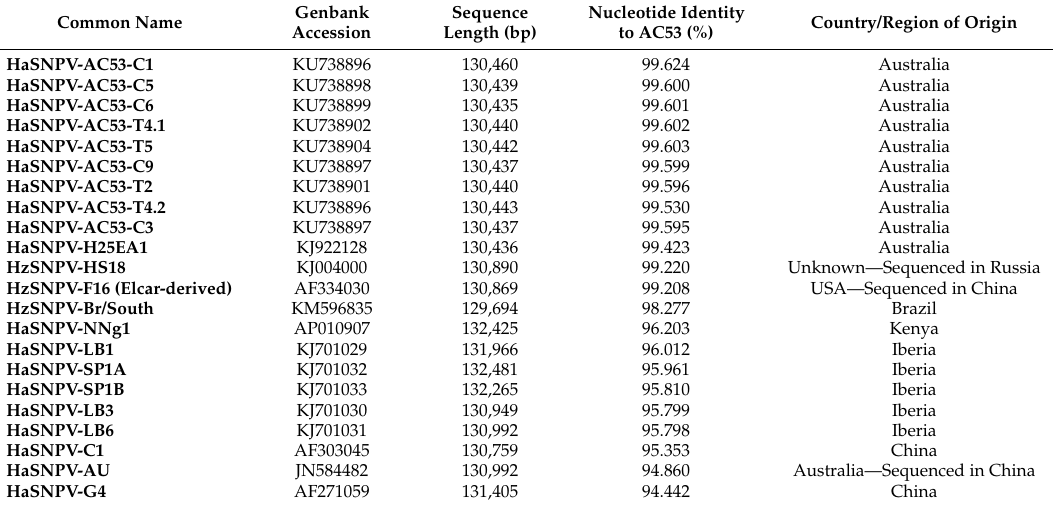
Sequenced H. armigera single nucleopolyhedrovirus (HaSNPV) and H. zea single nucleopolyhedrovirus (HzSNPV) nucleotide identity compared to AC53 with sequence identity ranging between 81.692% (L1 strain) and 99.604%